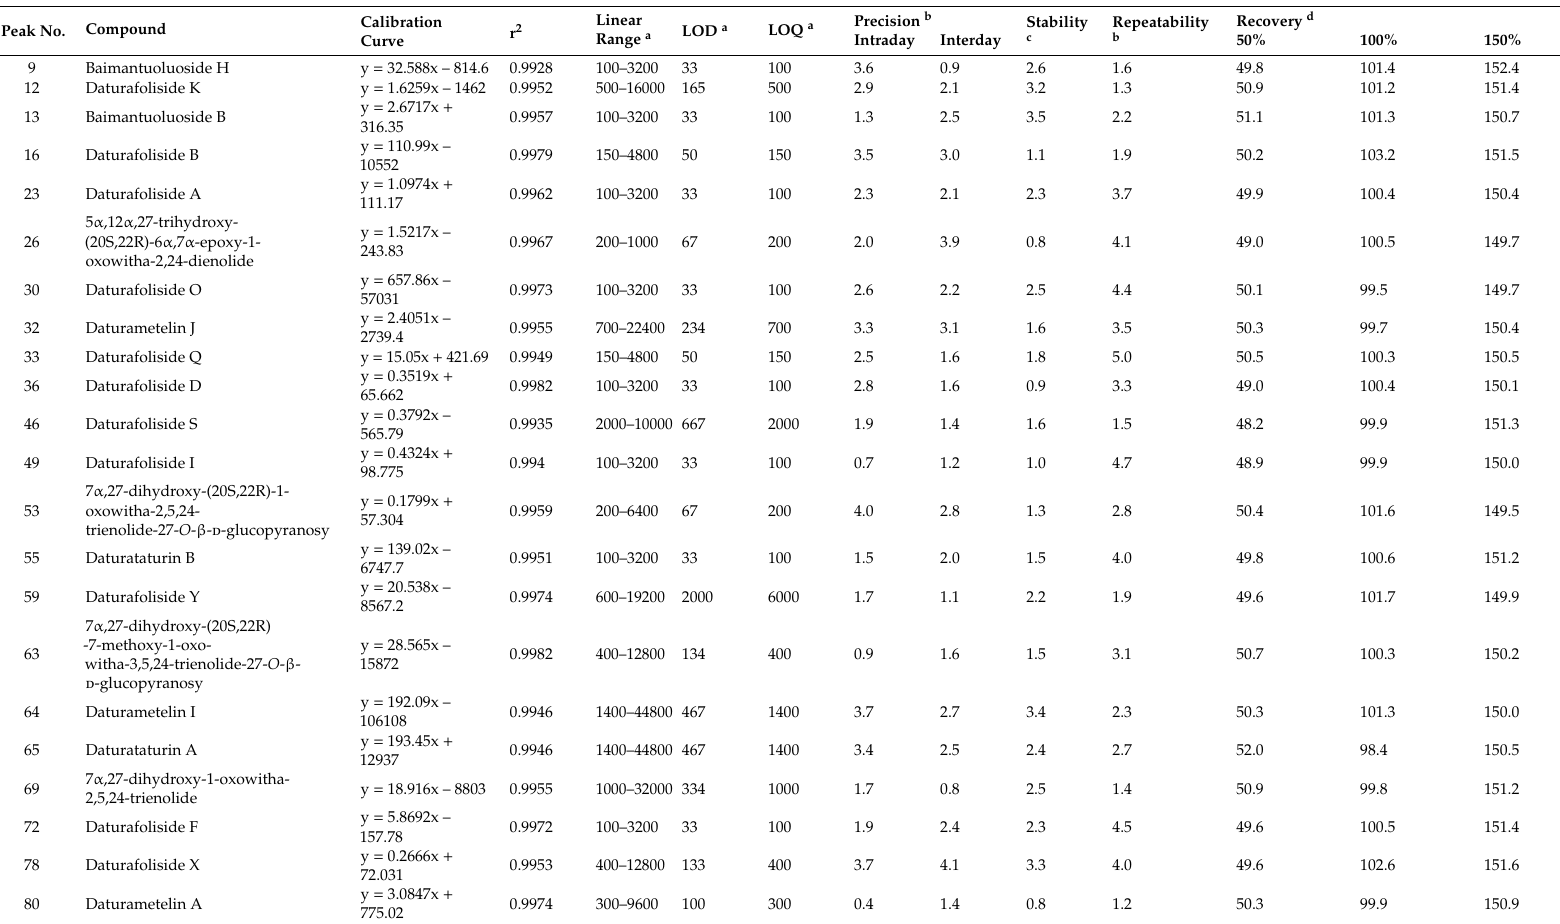
Table 2. Calibration curves and method validation data of the 22 bioactive withanolides by UPLC-Q-TRAP-MS /